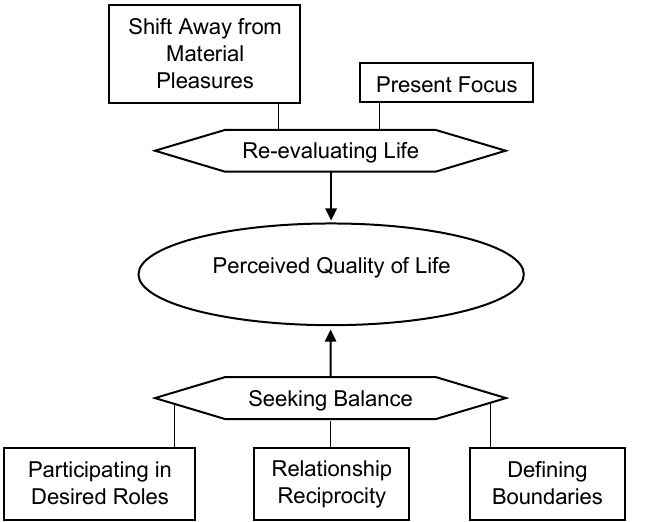
Figure 5. Visual map of Theme 4 by codes. Note. A line indicates that one component is a factor of another, and one arrow indicates a unidirectional in fl uence.